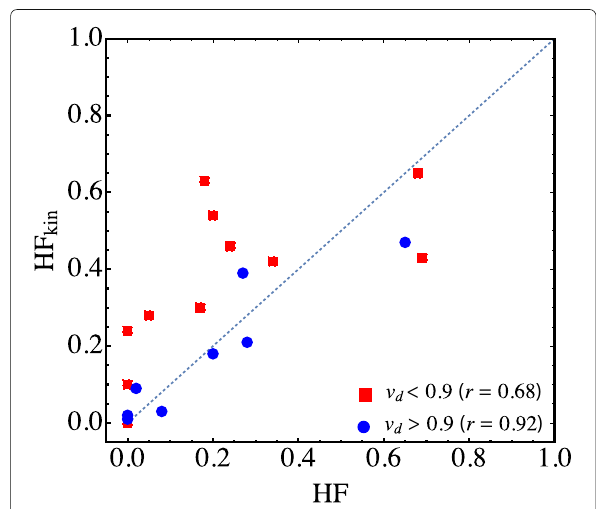
Fig. 6 Impact of transport on calculation of hypoxic fraction. When v d > 0.9, hypoxic fractions calculated from TBR>1.2 (HF) and k b > 0.2 h − 1 (HF kin ) are in substantial agreement. When v d < 0.9, correlations are greatly diminished ( r = 0.68), with HF underestimating